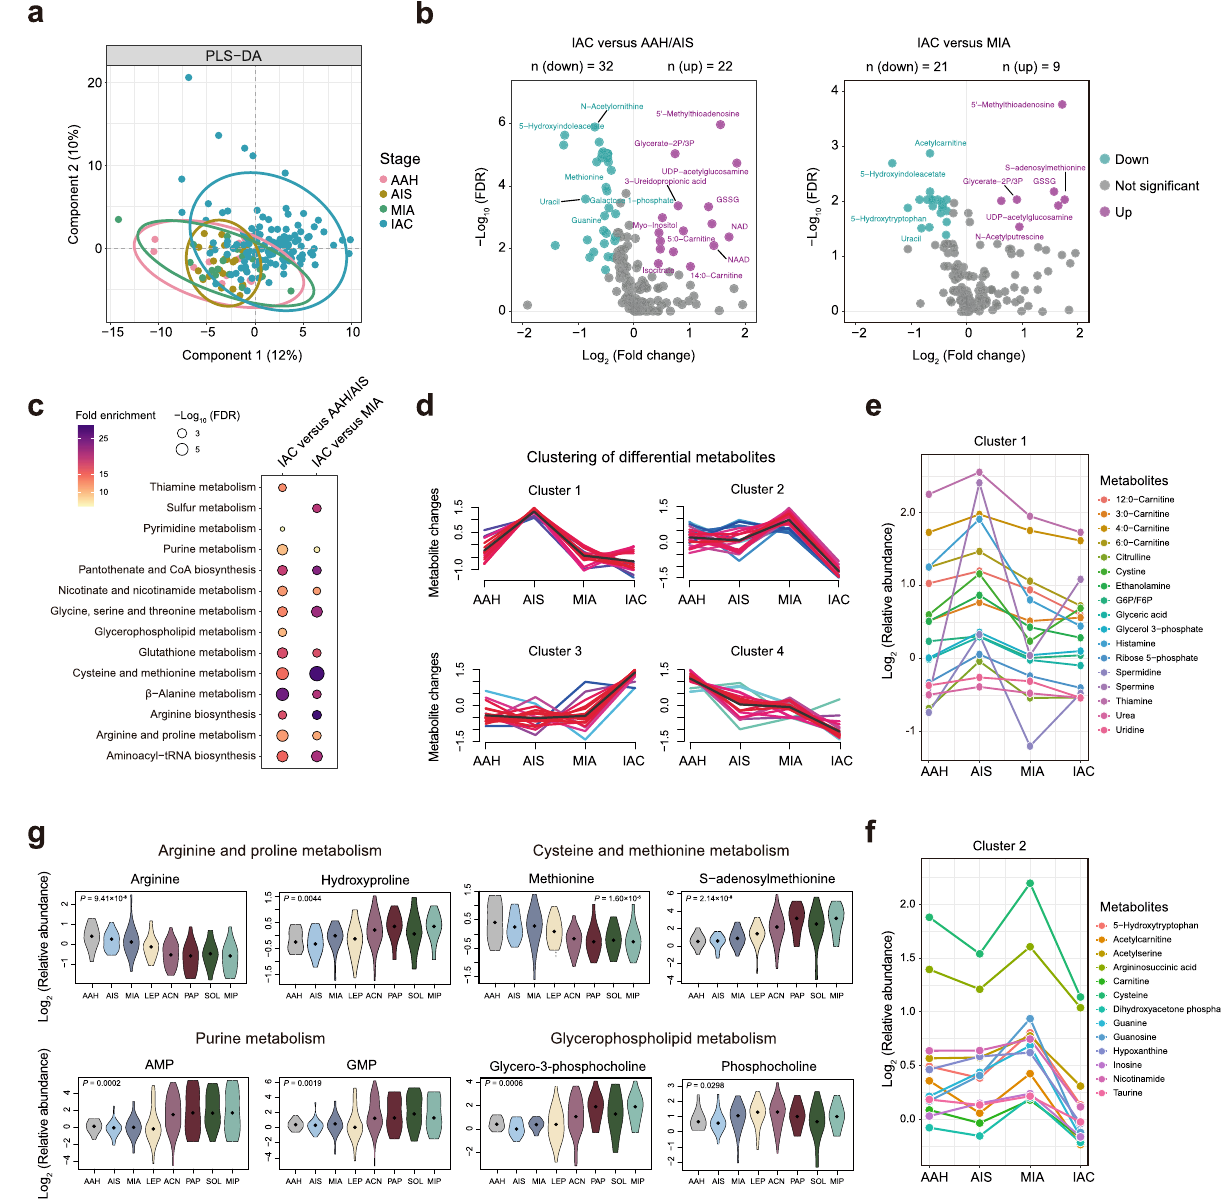
Fig. 2 Progressive metabolic evolution from AAH to IAC. a Partial least squares discriminant analysis (PLS-DA) of the metabolomics data from AHH, AIS, MIA, and IAC patients. b Volcano plots of the signi fi cantly differential metabolites in pre-invasive group (AAH/AIS) versus IAC or in MIA versus IAC were shown. Two-sided Wilcoxon rank-sum tests followed by Benjamini-Hochberg (BH) multiple comparison test with false discovery rate (FDR) < 0.05 and fold change > 1.25 or <0.8. Metabolites signi fi cantly increased or decreased were colored in purple and green, respectively. c Kyoto Encyclopedia of Genes and Genomes (KEGG) metabolic pathways enriched by signi fi cantly differential metabolites in pre-invasive group (AAH/AIS) versus IAC or in MIA versus IAC group. One-sided Fisher ’ s exact test followed by BH multiple comparison test with FDR < 0.05. d Clustering of metabolic trajectories using differential metabolites among AAH, AIS, MIA, and IAC. Two-sided Kruskal-Wallis tests followed by BH multiple comparison test with FDR < 0.1. e , f Dynamic alterations of metabolites in cluster 1 and cluster 2. The dots represent the mean log 2 relative abundance. Two-sided Kruskal-Wallis tests followed by BH multiple comparison test with FDR < 0.1. g Violin plots of metabolites in cluster 3 and cluster 4. The difference of metabolites among AHH, AIS, MIA, and IAC were evaluated using a two-sided Kruskal-Wallis test. Black dots represent population regression models based on differential metabolites between two given groups (benign diseases versus AIS/MIA/IAC, benign dis- eases versus AIS/MIA, benign diseases versus AIS). A biomarker panel of four metabolites with Area Under Curve (AUC) of 0.894, enabling the discrimination between benign diseases and LUAD groups (AIS/MIA/IAC), was identi fi ed (Fig. 3b). The panel con- sisted of 3-chlorotyrosine, 12:0-carnitine, glutamate, and phos- phocholine. The levels of 3-chlorotyrosine and phosphocholine